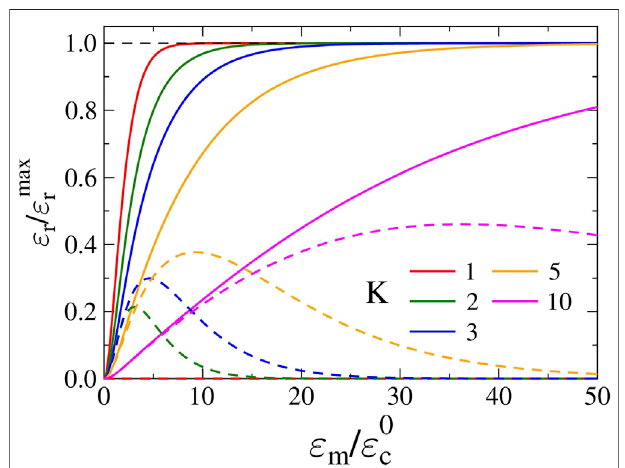
FIGURE 5 | Permanent deformation ε r of hardening (continuous lines) and softening (dashed lines) stick-slip bundles as function of the maximum deformation ε m reachedbeforeunloadingstartedfordifferentvaluesoftheslip number K at the stiffness parameter a (cid:1) 0 . 8. The remaining deformation ε ε max r isscaled withthecorresponding maximumvalue r ofthehardeningcase given by Eq. 14 . For softening bundles a non-monotonous behavior is obtained. Additionally, even the maximum values of the ε r ( ε m ) curves fall below the corresponding curves of hardening bundles.